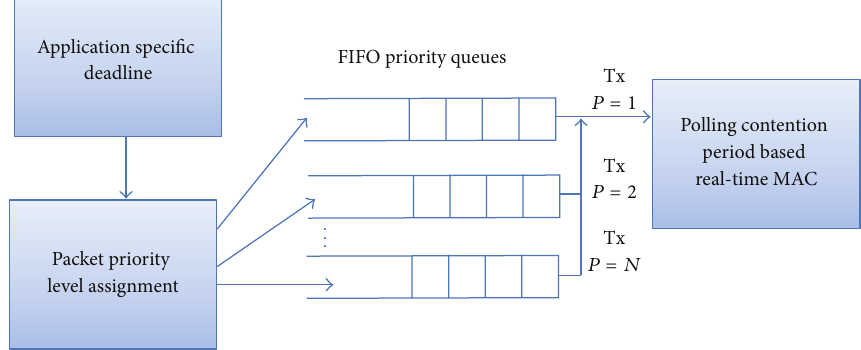
Figure 3: Traffic classification using priority